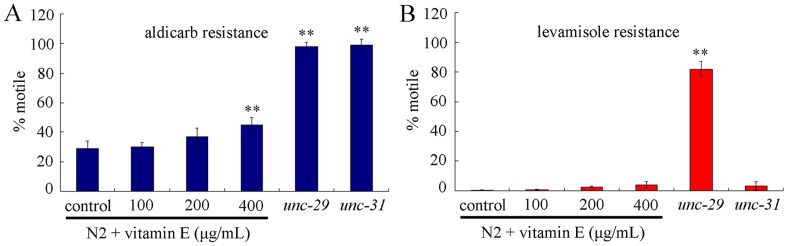
Effects of vitamin E treatment at different concentrations on synaptic neurotransmission in C. elegans.(A) Effects of vitamin E treatment on presynaptic function as evaluated by aldicarb resistance. (B) Effects of vitamin E treatment on postsynaptic function as evaluated by levamisole resistance. Data are expressed as mean ± SEM. **p<0.01 vs. control.